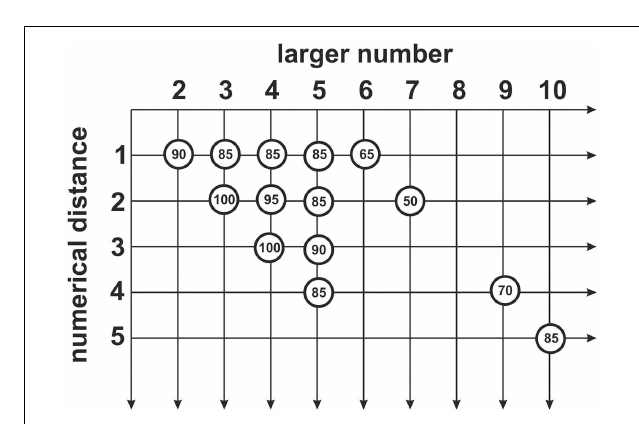
FIGURE 6 |The figure indicates the larger number within each pair as well as the difference between this pair of stimuli. The number within the circles indicates the achieved performance of Blue.The data show that Blue had more difficulties in discriminating higher numerosities with small differences between the two